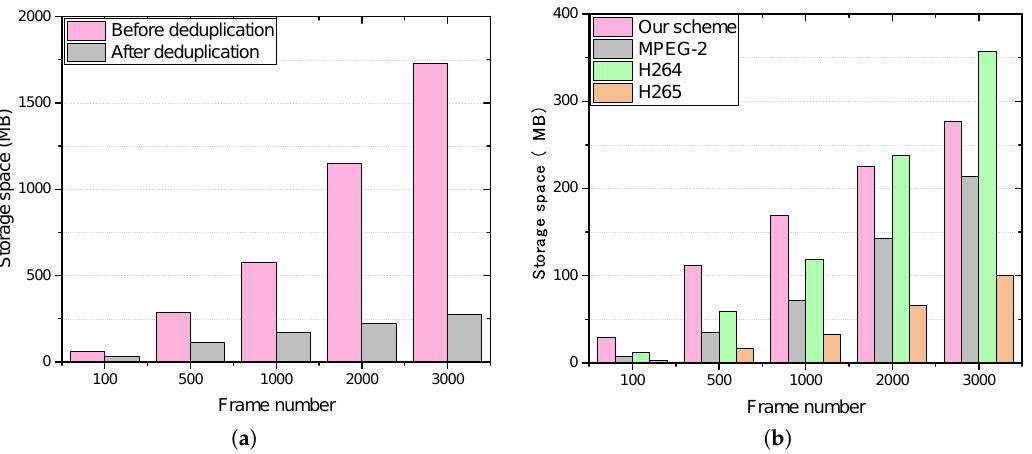
Figure 6. ( a ) Comparison of storage space between before and after removal in the proposed system; ( b ) comparison of storage space between the proposed system and compression algorithms.